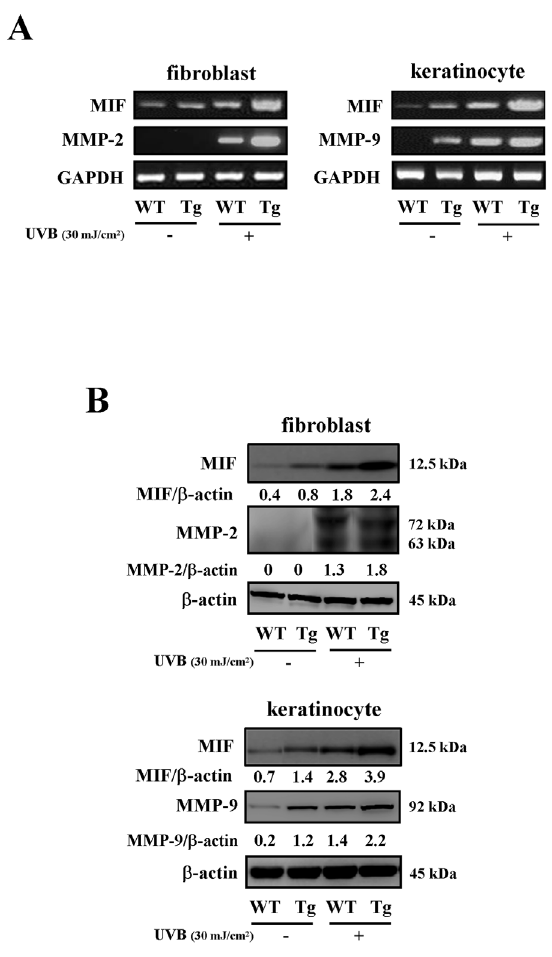
Figure 5. Enhanced expression and production of MMP-9 and MMP-2 in the keratinocytes and fibroblasts of the MIF Tg mice following acute UVB exposure. (A) The expressions of MIF, MMP-2 and MMP-9 mRNA were examined. Total RNA was isolated at six hours after UVB irradiation (30 mJ/cm 2 ) and analyzed with RT-PCR (n=5). (B) Western blot analysis of MIF, MMP-2 and MMP-9 was performed 24 hours after UVB (30 mJ/cm 2 ) on the production of these com- pounds. The band of b -actin was used to normalize the expression level. A densitometric analysis was also performed to evaluate the intensity of each band. The data shown are representative of three independent experiments.